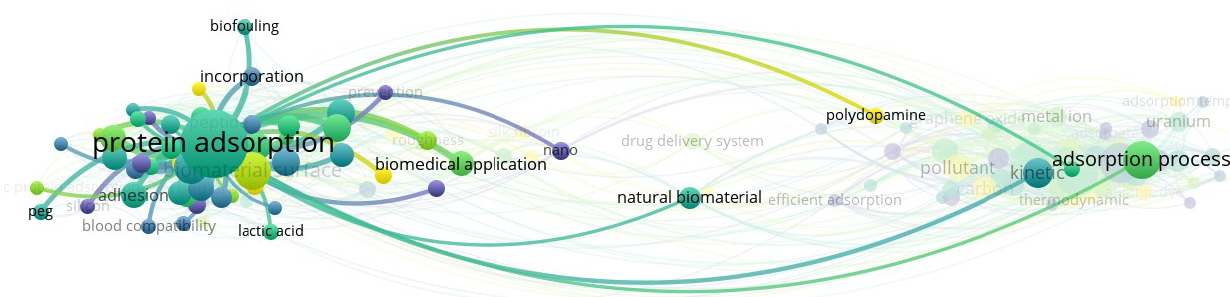
Fig. 6. Network Visualization of Biomaterial Adsorption Publication